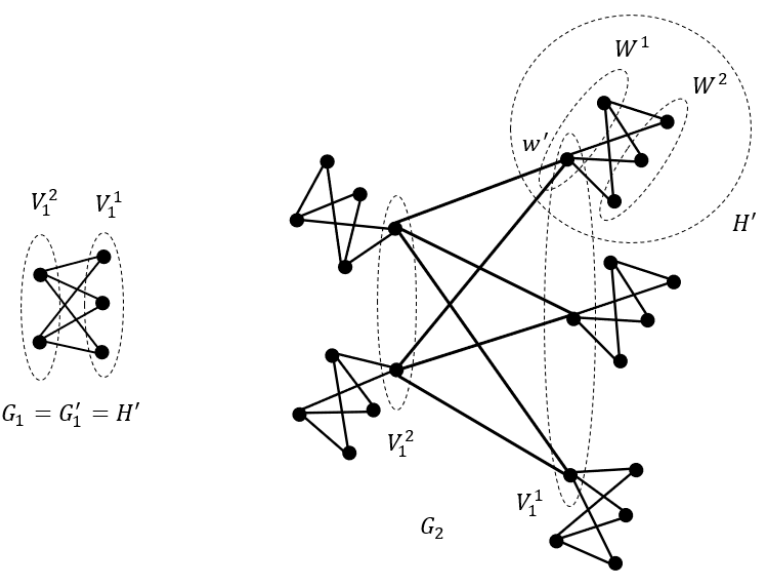
Figure 8. Prefractal graph G 2 generated by a complete bipartite seed, preserving the adjacency of old edges.